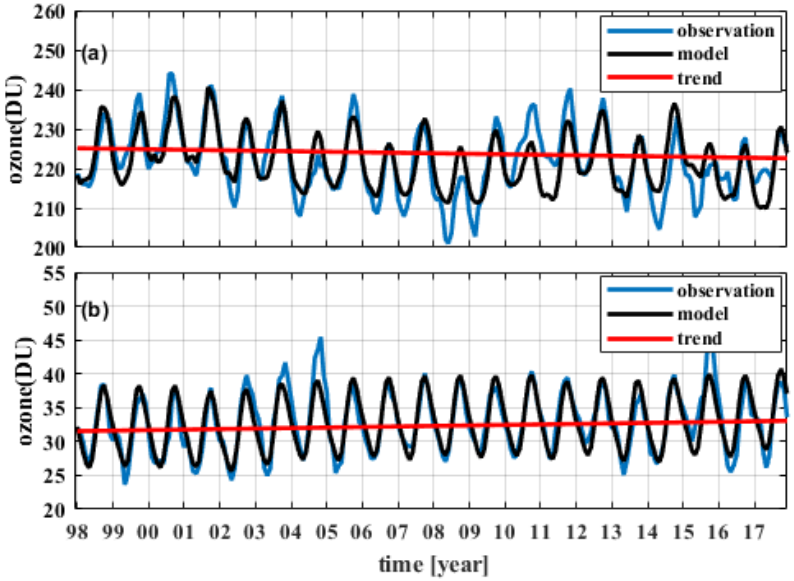
Figure 9. Time evolution of monthly ozone values: panel ( a ) and panel ( b ) represent stratospheric and tropospheric partial columns, respectively. Observational data are represented by blue line and simulated data are presented in black. The straight red lines illustrate the linear trend obtained by the Trend-Run model.